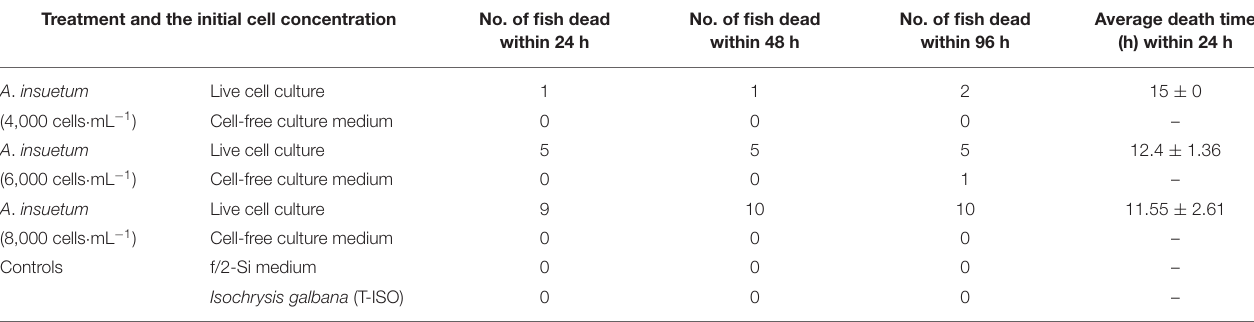
TABLE 1 | Fish bioassays using partitioned culture plates showing the toxicity of live cell culture and cell-free culture medium within 96h. Treatment and the initial cell concentration No. of fish dead